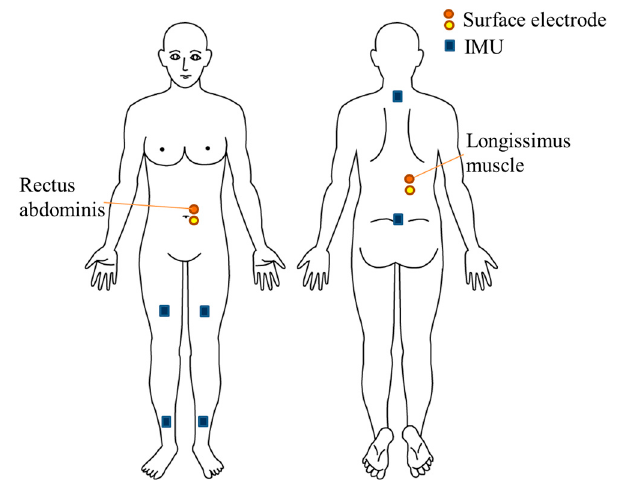
Figure 2. Position of the IMUs and surface electrodes.